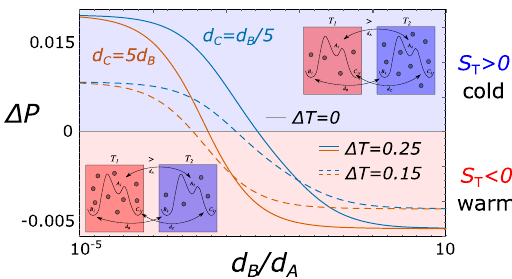
Fig. 4 Thermophoresis as selection in space for a three-state two-box model. Difference between the probability of being in each box, Δ P = P 2 − P d d d = d 1 , as a function of B / A (in log-scale), for C B /5 (blue curves) and d = 5 d Δ T are shown. C B (vermilion curves). Different values of the gradient When Δ P is positive, the particles (independently of the species) accumulate on the cold side (blue/right box), and the Soret coef fi cient S T is positive. On the contrary, the particles are more abundant in the warm side (red/left box) for negative Δ P , corresponding to negative values of S T . In this example, we set T m = 0.7, Δ E = 0.1, Δ ϵ = 2 and, d A = 0.01. k B has been taken equal to 1 for